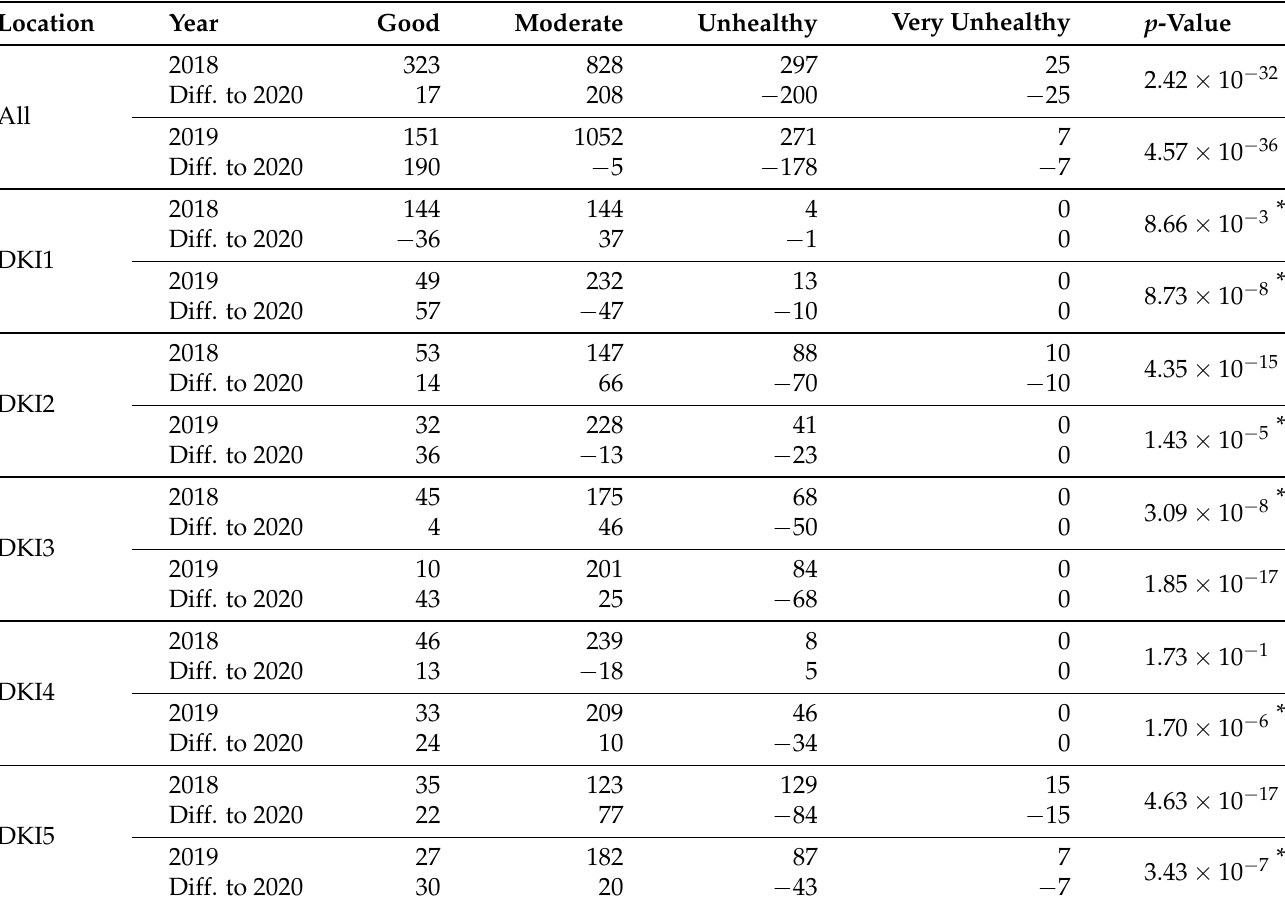
Table 4. The comparison of AQI from the year of 2018 and 2019 to 2020 based on the measurement location in Jakarta. Location Year Good Moderate